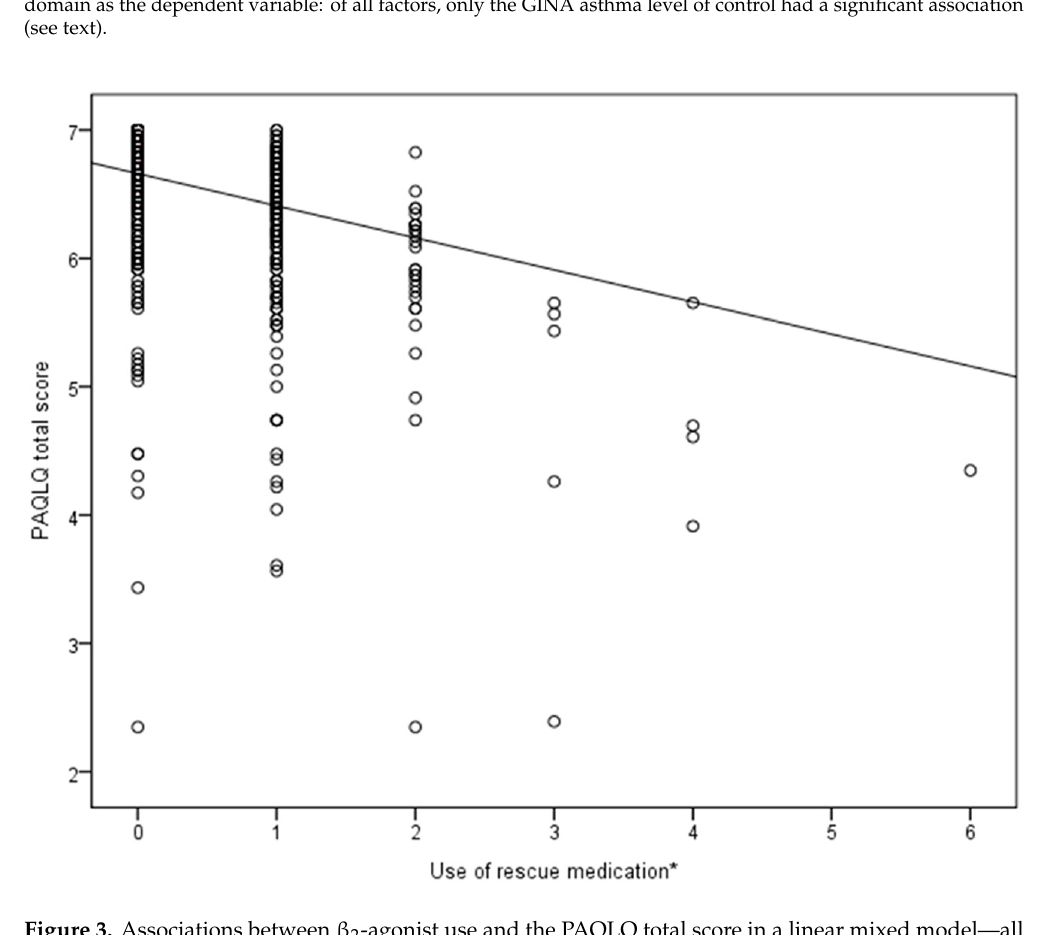
smoke. * Increase in the PAQLQ score for an increase of the level of control from uncontrolled to partly controlled to